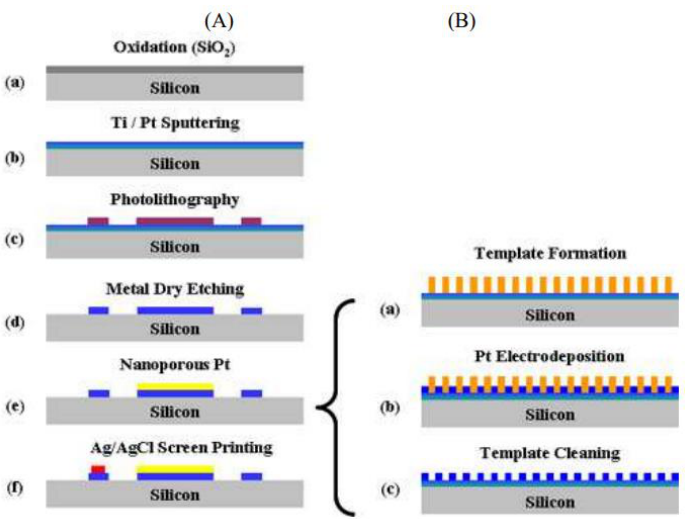
Figure 6. Fabrication procedures of non-enzymatic glucose micro-sensor with nanoporous Pt WE ( A ) and nanoporous Pt electrode ( B ) on silicon substrate. Reprinted from Ref. [58].